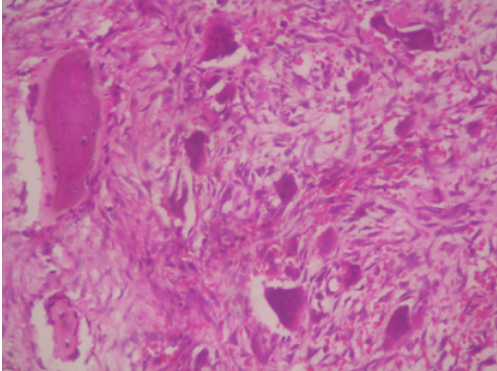
Figure 3: Histopathological examination showing giant cells mixed with mononuclear cells devoid of atypia consisting with hyperpara- thyroidism (high magnification).